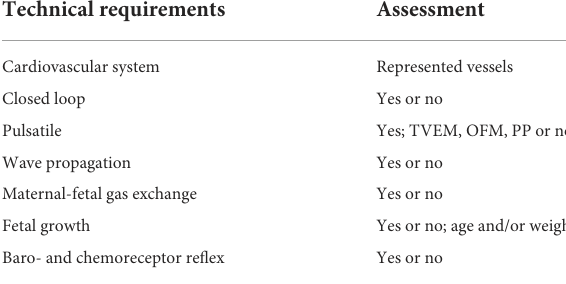
TABLE 1 Technical requirements and their